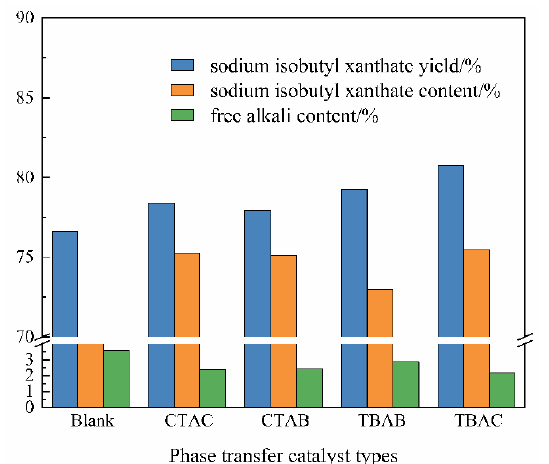
Figure 1. The effect of catalyst types on the content and yield of sodium isobutyl xanthate.